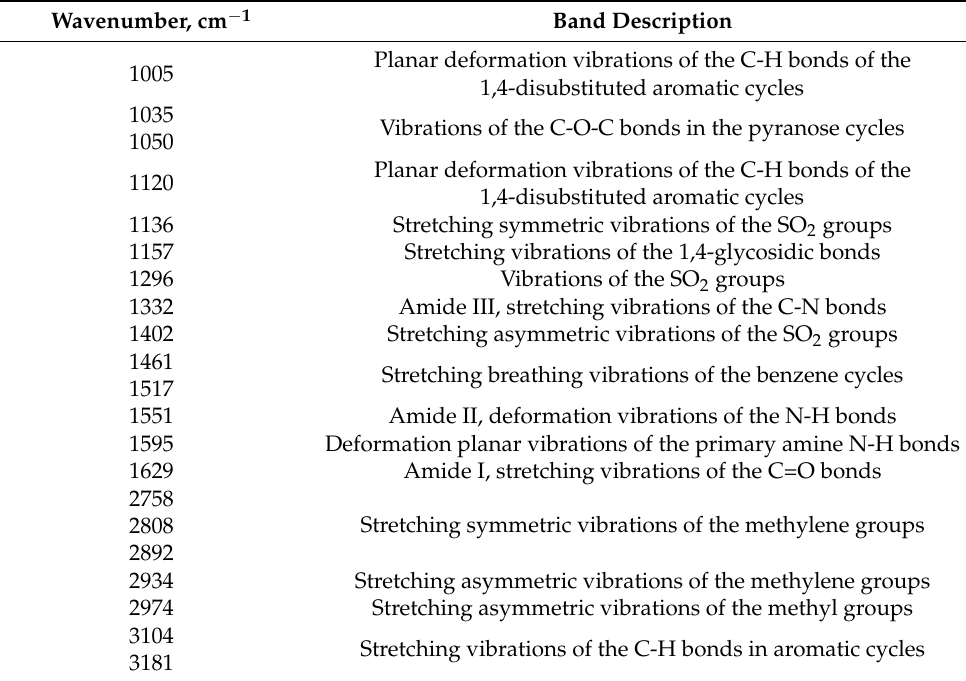
Table 1. 2-(4-Acetamido-2-sulfanilamide) chitosan FTIR spectrum band description [37–41]. Wavenumber, cm − 1 Band Description